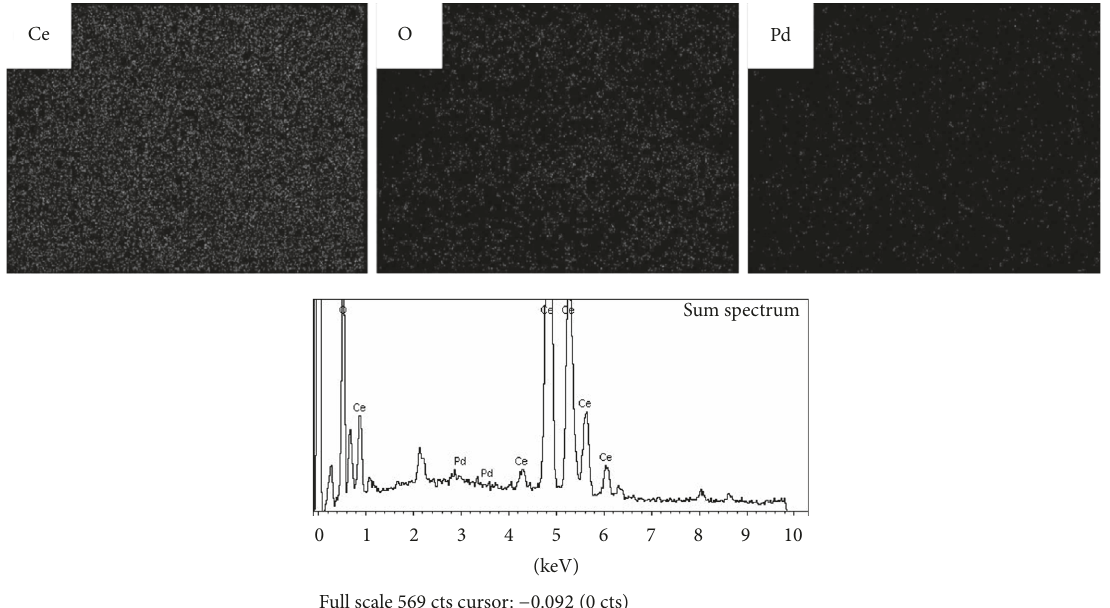
Figure 4: EDX mapping of cerium, oxygen, and palladium within 1Pd-CeO2-B-N showing a good distribution of the three elements within the material matrix and its corresponding EDX spectrum based on SEM